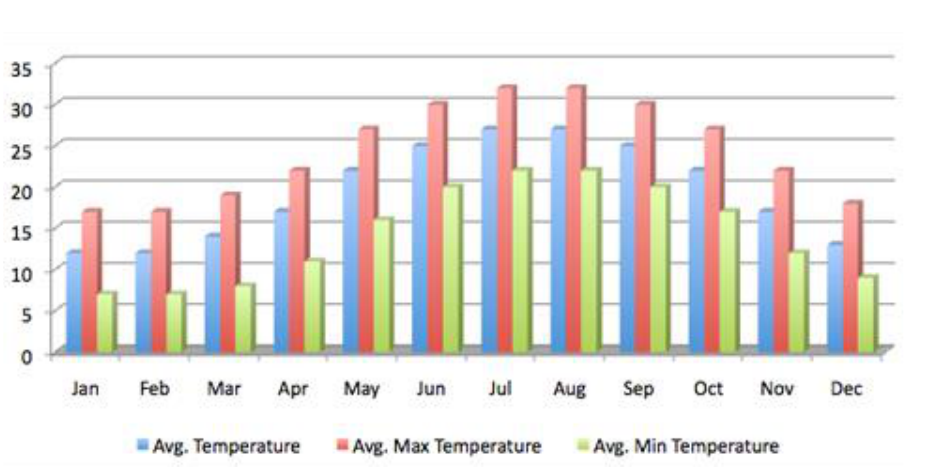
Figure 1. Average weather temperature in Cyprus during